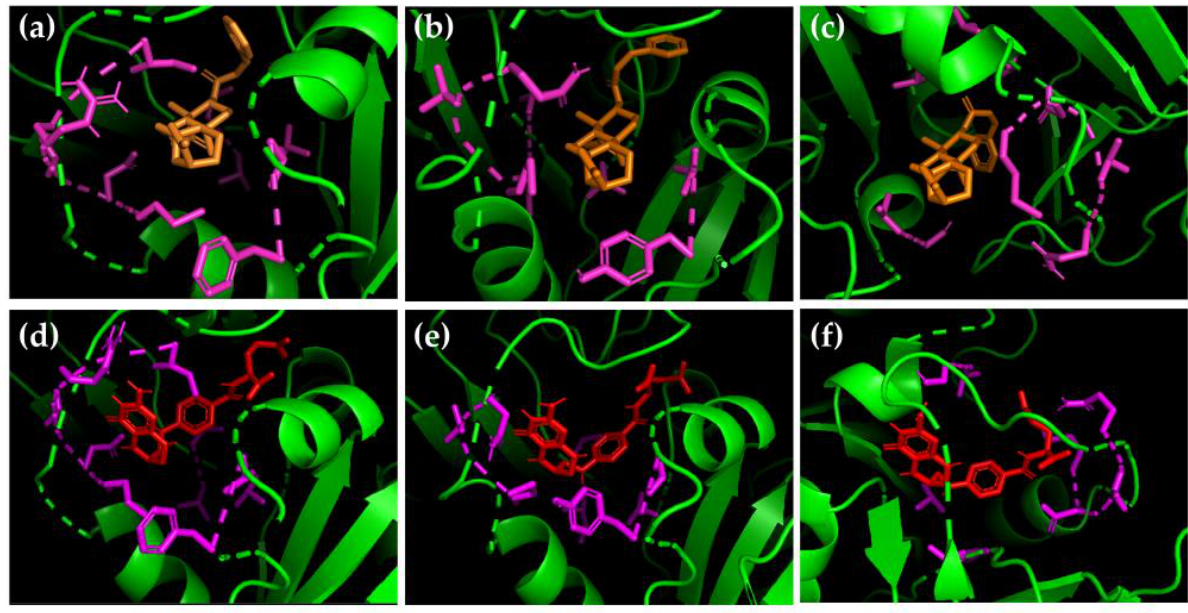
Figure 3. Best pose of structure 302 (orange) and MTX (red) in the active site of ( a – d ) L. amazonensis ( b – e ) L. braziliensis and ( c – f ) L. panamensis DHFR-TS (green). Flexible amino acids are marked in pink. In the same manner, L. amazonensis exhibited a behavior similar to that of L. braziliensis , with VINA score values ranging from − 10.52 to − 11.14 kcal/mol, all of which showed lower affinity values compared to MTX ( − 9.54 kcal/mol). The latter only showed three interactions with the flexible residues in the active site of the enzyme, including two van der Waals interactions with V49 and Q48 and a π -sulfur interaction between the sulfhydryl group of M53 and the pteridine ring. Structures 301 and 302 displayed the same